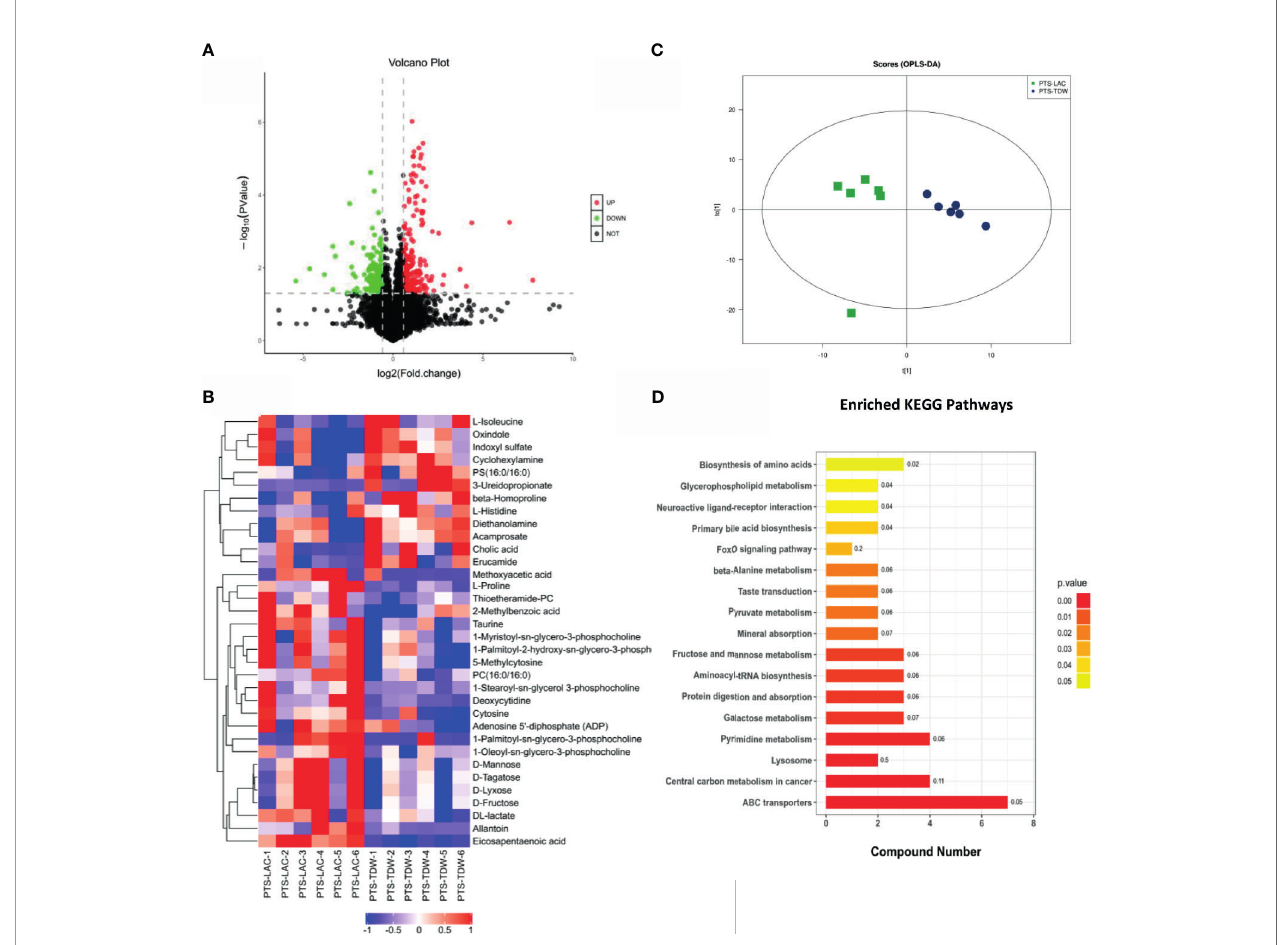
FIGURE 6 | (A) Volcano plot for the PTS_LAC and PTS_TDW groups in the positive mode. Red and green dots indicate signi fi cant differential metabolites with fold changes >1.5 and p values <0.05. (B) Heatmap showing normalized values of 34 metabolites that were differentially abundant among the PTS_LAC and PTS_TDW groups. (C) Orthogonal partial least squares discrimination analysis: score plots of the PTS_LAC and PTS_TDW groups in the positive ion mode. (D) Kyoto Encyclopedia of Genes and Genomes pathways enriched in the PTS_LAC group compared with the PTS_TDW